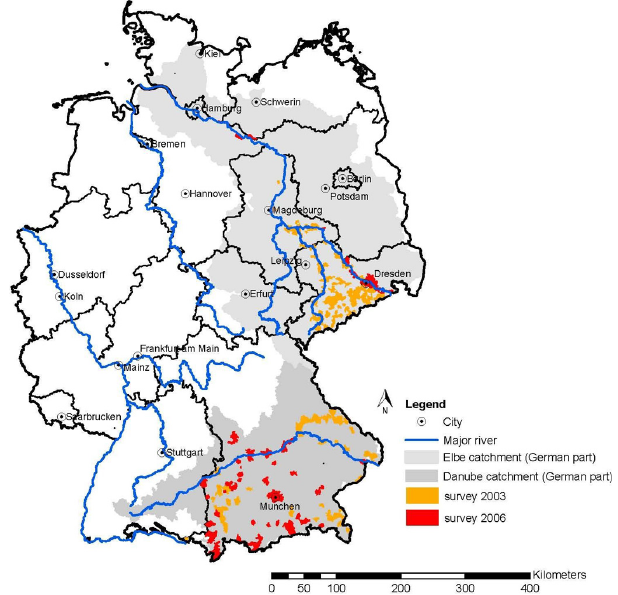
Fig. 2. Sample area of the survey in the Elbe (Eastern Germany) and Danube (Western Germany) catchments in Germany (data sources: rivers and administrative boarders: DLM1000 of BKG (2001); cities: Esri, DeLorme Publishing Company, inc.; catchment areas: CCM2 data of JRC, Vogt et al.